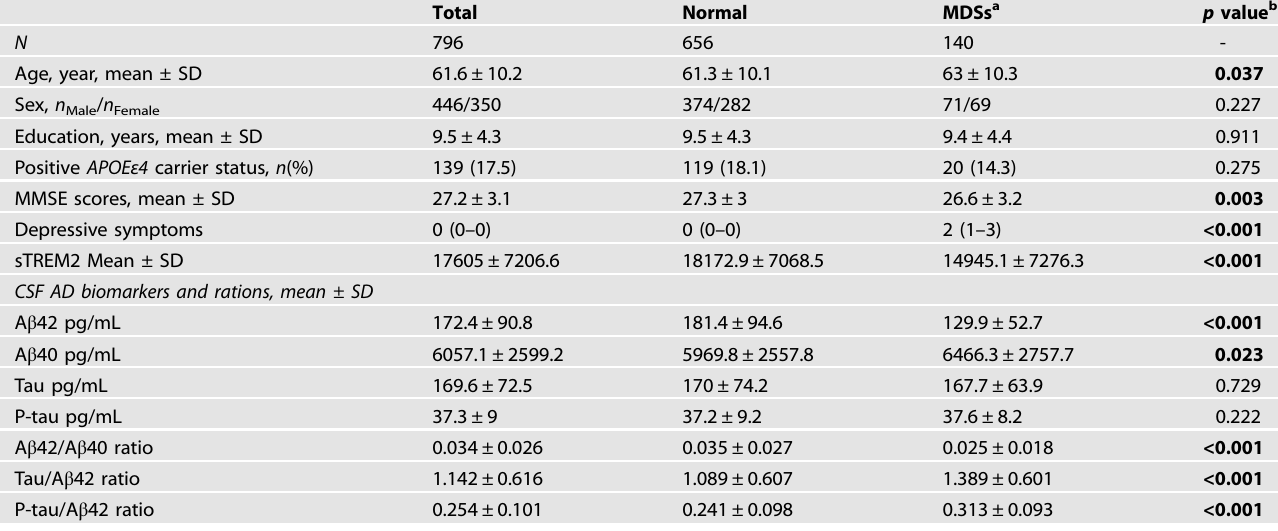
Table 1. Characteristics of